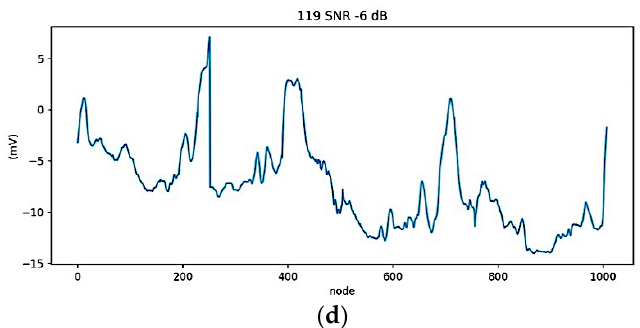
Figure 2. Electrocardiogram (ECG) raw data with noise. ( a ) Record 118 (24 dB), ( b ) Record 118 ( − 6 dB),